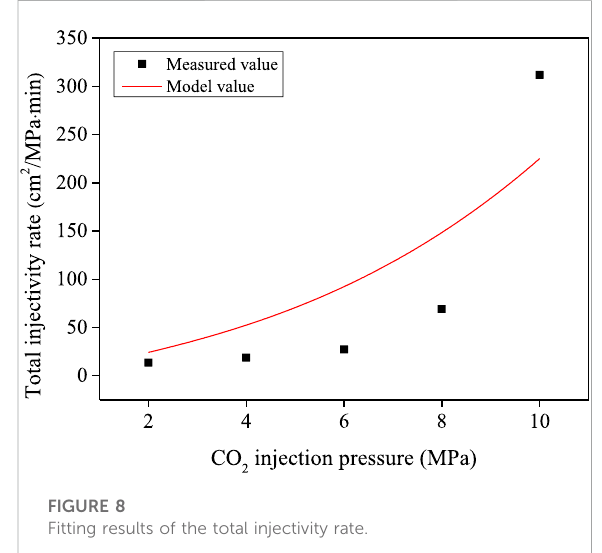
FIGURE 8 Fitting results of the total injectivity rate.